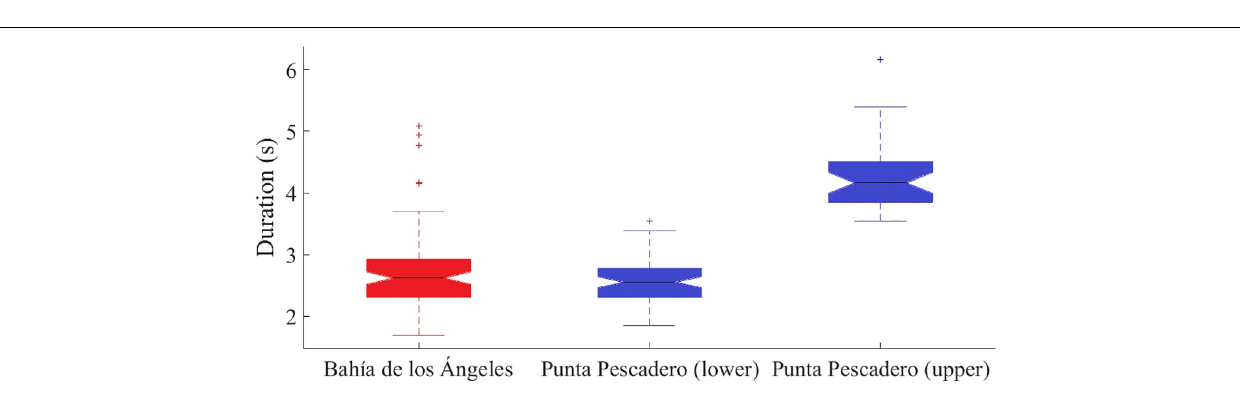
FIGURE 8 | Boxplots showing the first quartile, median, third quartile of the call duration distribution of Bryde’s whale from the north (Bahía de Los Ángeles, Baja California) from November 2006 to June 2007, and the two suggested distributions in the south (Punta Pescadero, Baja California Sur) from August to December 2008. Both distributions in the south are significantly different between each other ( p = < 0.00001). Outliers are represented as